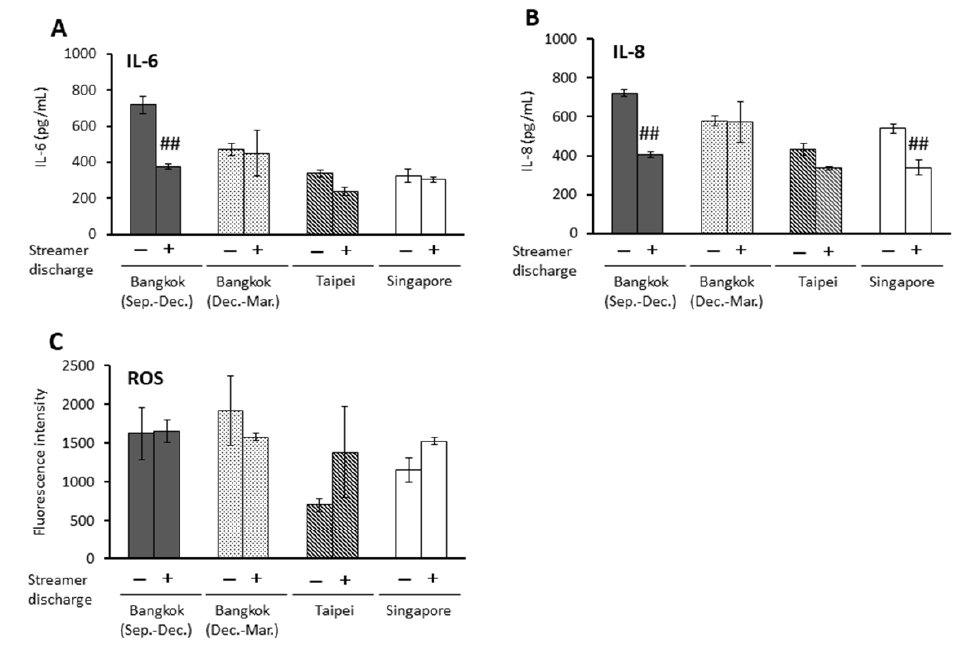
Figure 3. Effects of streamer-discharged PM2.5 at a dose of 75 μ g/mL on proinflammatory responses and oxidative stress in BEAS-2B cells. ( A ) IL-6 release, ( B ) IL-8 release, ( C ) ROS production. ## p < 0.01 vs. non-treated PM2.5.